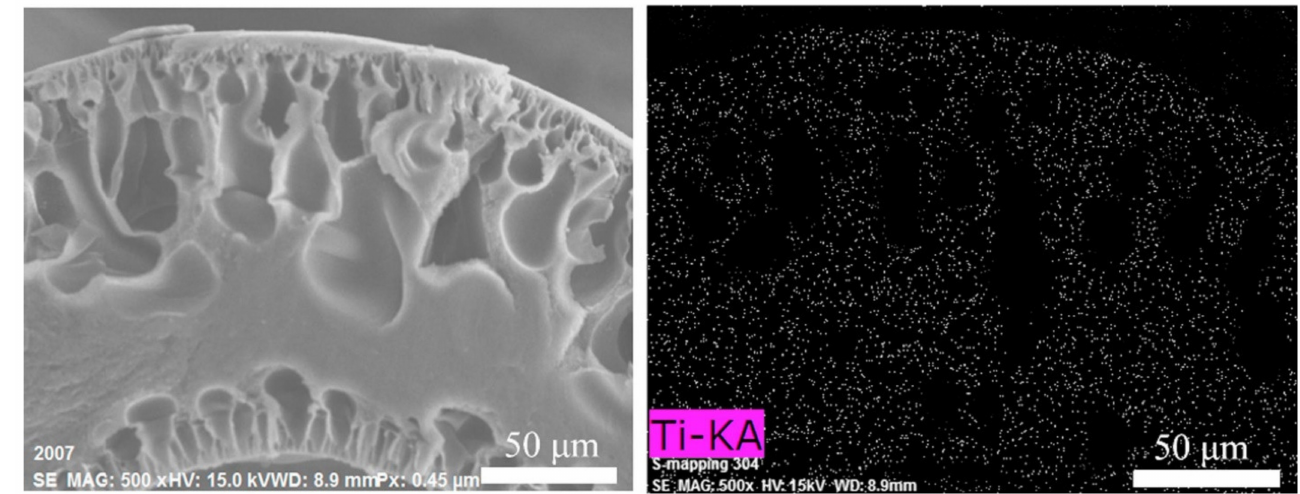
Figure 6. The SEM observation and EDS analysis of the cross-section of PAA HF MMMs, which shows the nanofillers are uniformly distributed in the HF cross-section. Reprinted with permission from Ref. [60], Copyright 2019, Elsevier.